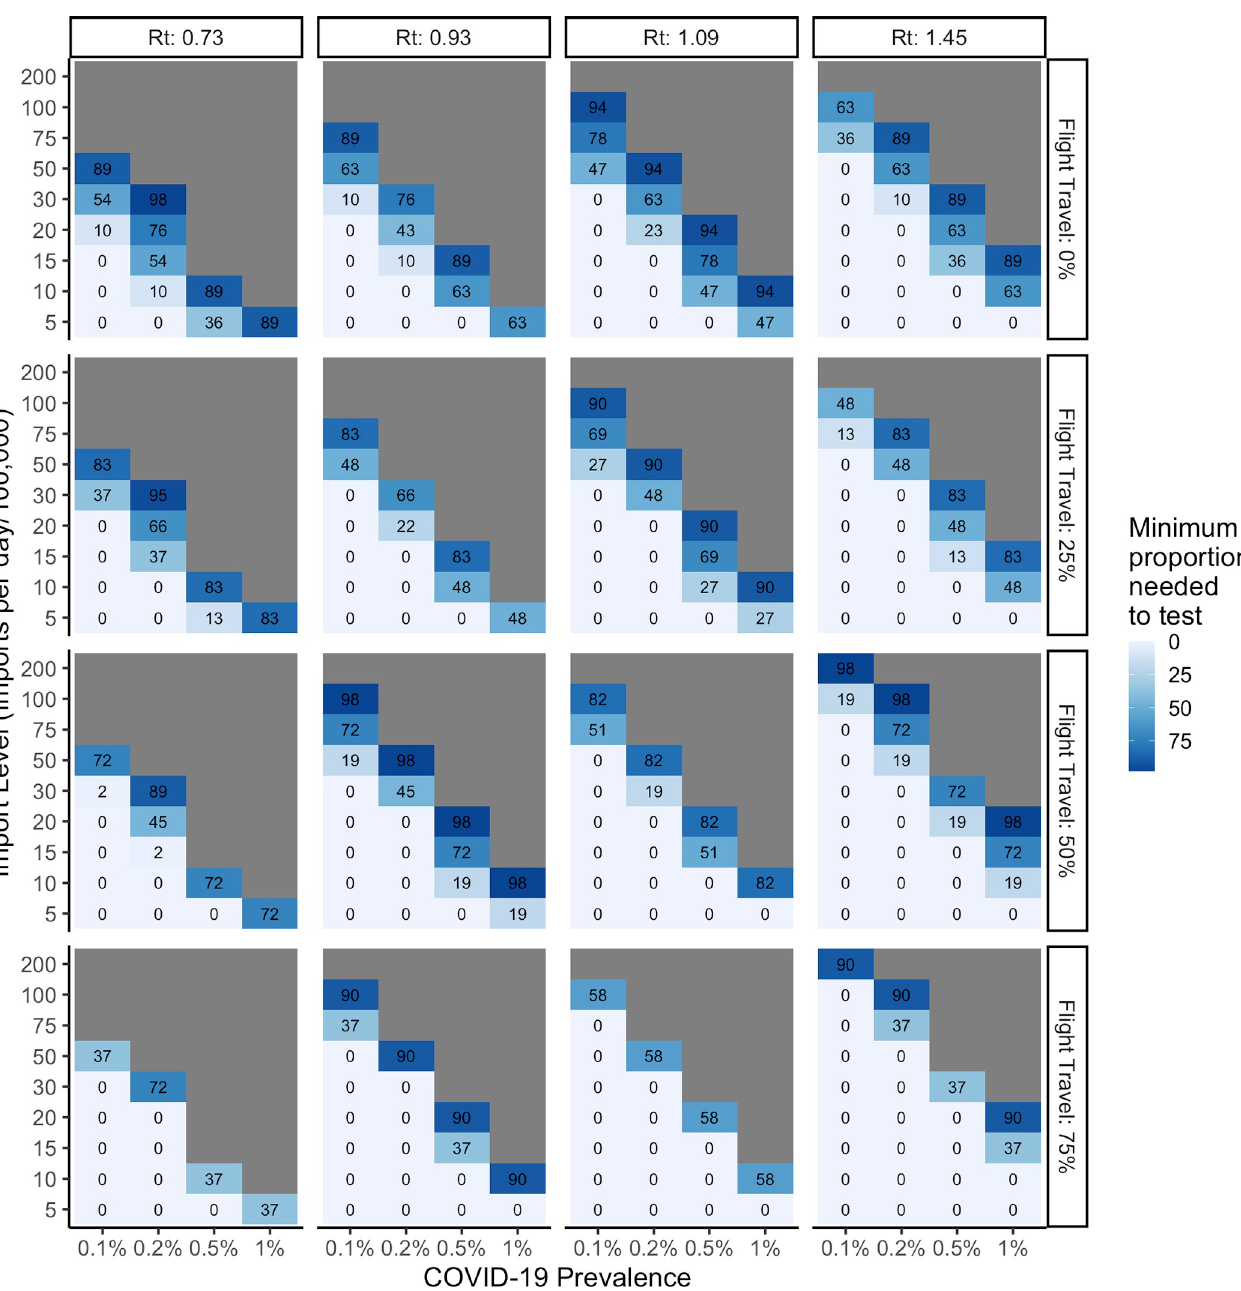
Fig 3. Impact of increasing proportion of flight travel on the minimum proportion of arrivals to be screened per day at land border crossings using SARS-CoV-2 Ag-RDTs when varied by the reproductive number at time t , number of arrivals per day, and prevalence of COVID-19 among arrivals. Ag- RDT sensitivity is set to